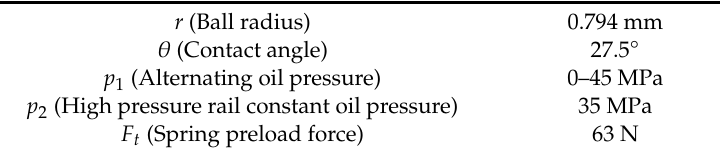
Figure 2. The stress state of the pressure relief valve. Table 1. The parameters of structure and oil pressure.